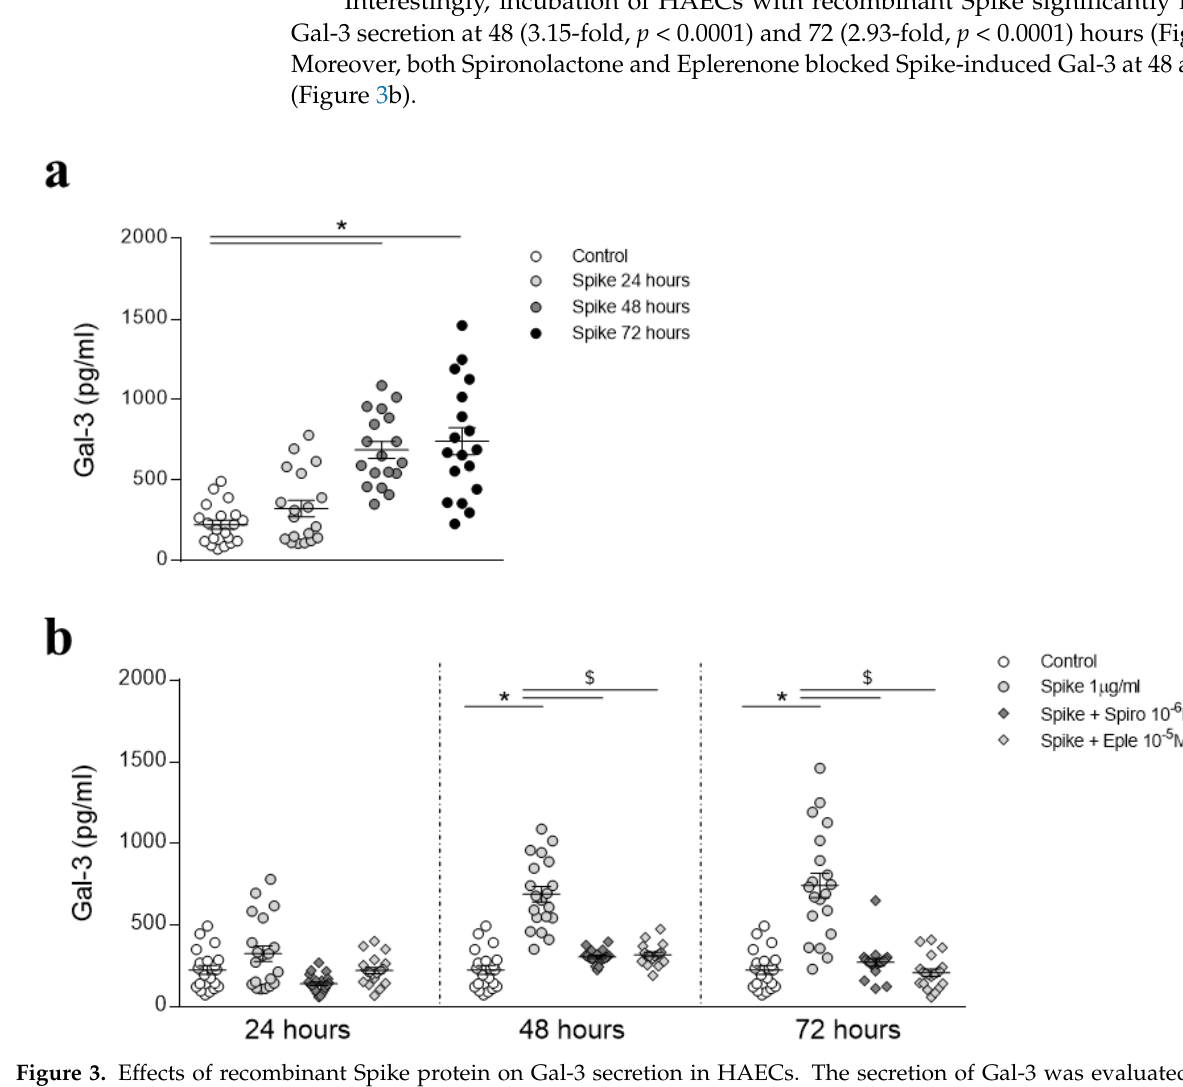
Figure 3. Effects of recombinant Spike protein on Gal-3 secretion in HAECs. The secretion of Gal-3 was evaluated in HAECs treated with recombinant Spike protein for 24, 48, and 72 h ( a ). Gal-3 extracellular levels were measured in HAECs pre-treated with Spironolactone or Eplerenone and then treated with Spike for 24, 48, or 72 h ( b ). Control, n = 20; Spike, n = 20; Spike + Spiro, n = 20; Spike + Eple, n = 20. Results were analyzed using one-way-ANOVA followed by Dunnet’s post-hoc multiple comparisons tests. * vs. control; $ vs. Spike.